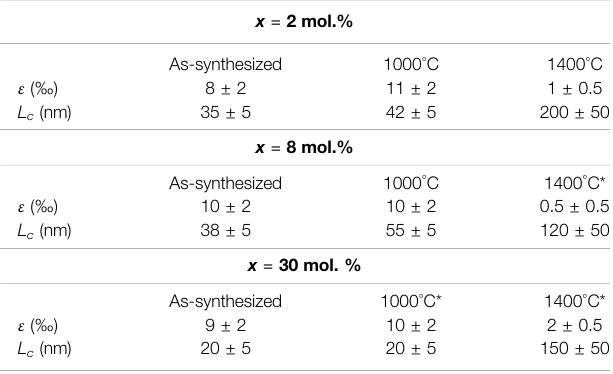
TABLE 3 | Coherence length, Lc, and internal strains, ε , of YAG:Ce samples with different x. x = 2 mol.% As-synthesized